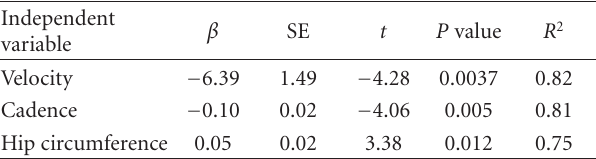
Table 5: Parameter estimates from multiple linear regression with TUG as dependent variable adjusted for age and